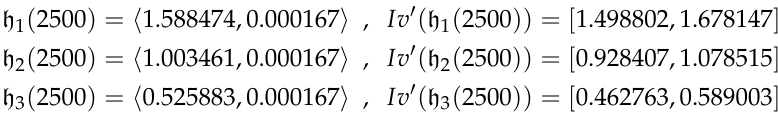
Figure 5. Extended three-tank system. Simulation results for the three state variables using real numbers.The dark bands are only apparent. They are the accumulation of the 1000 little vertical segments which represent the intervals associated to the resulting marks in the 1000 simulation points